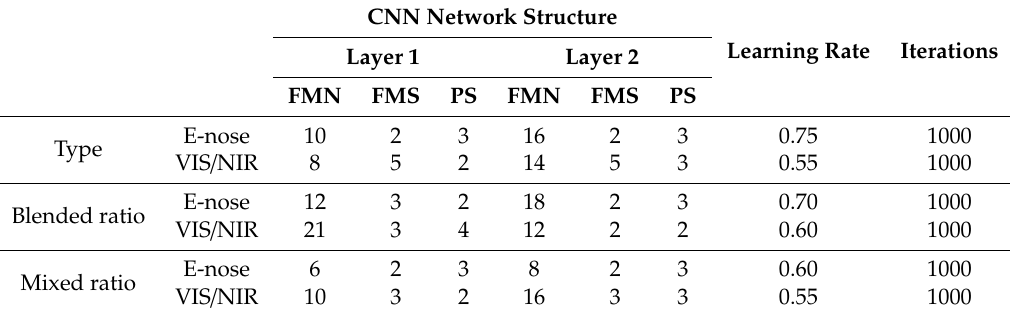
Table 4. Paremeter setting of CNN feature